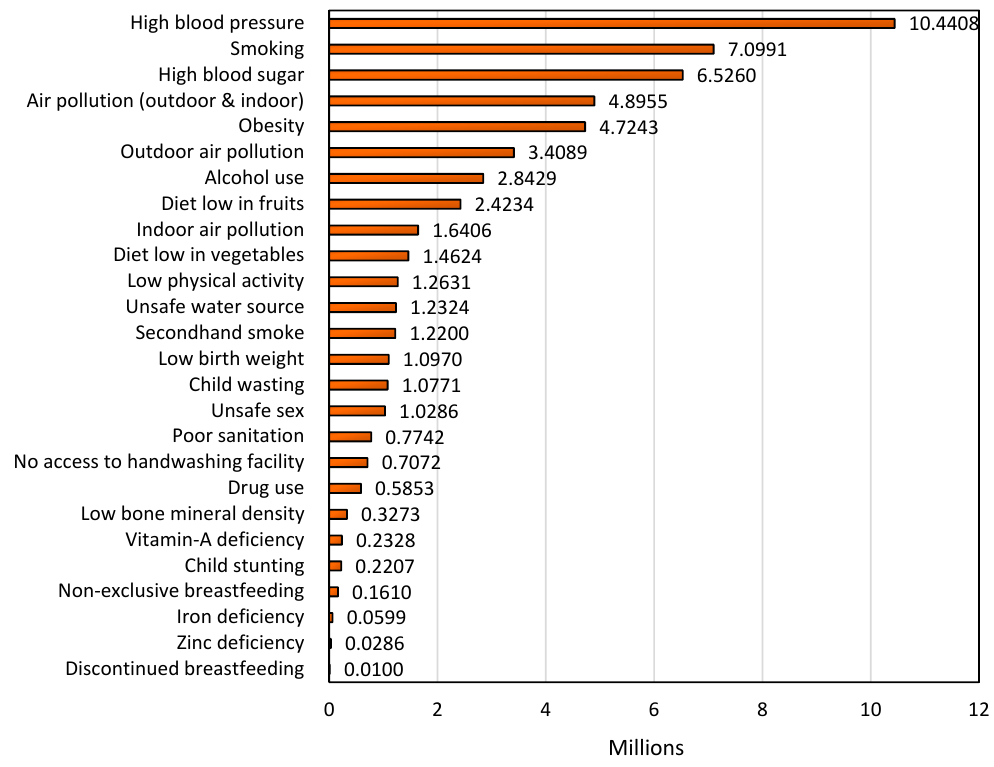
Figure 18. Total annual number of deaths by risk factor, World, 2017. The data were collected measured across all age groups and both sexes. Information provided by Hannah Ritchie and Max Roser (2019) in “Causes of Death,” published online at OurWorldInData [86]. Table 1. Groups of diseases or health burden according to the Institute of Health Metrics and Evaluation (IHME). Information is from Max Roser and Hannah Ritchie [86], “Burden of Disease,” published online at OurWorldInData.org. Communicable, Maternal, Neonatal, and Nutritional